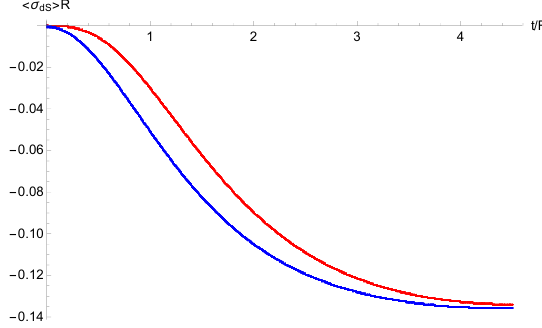
Figure 10 . The evolution of h (cid:27) dS i ren for the free theory with Bunch-Davies (blue) and equilibrium (red) initial conditions, and M 2 R 2 = 0 :